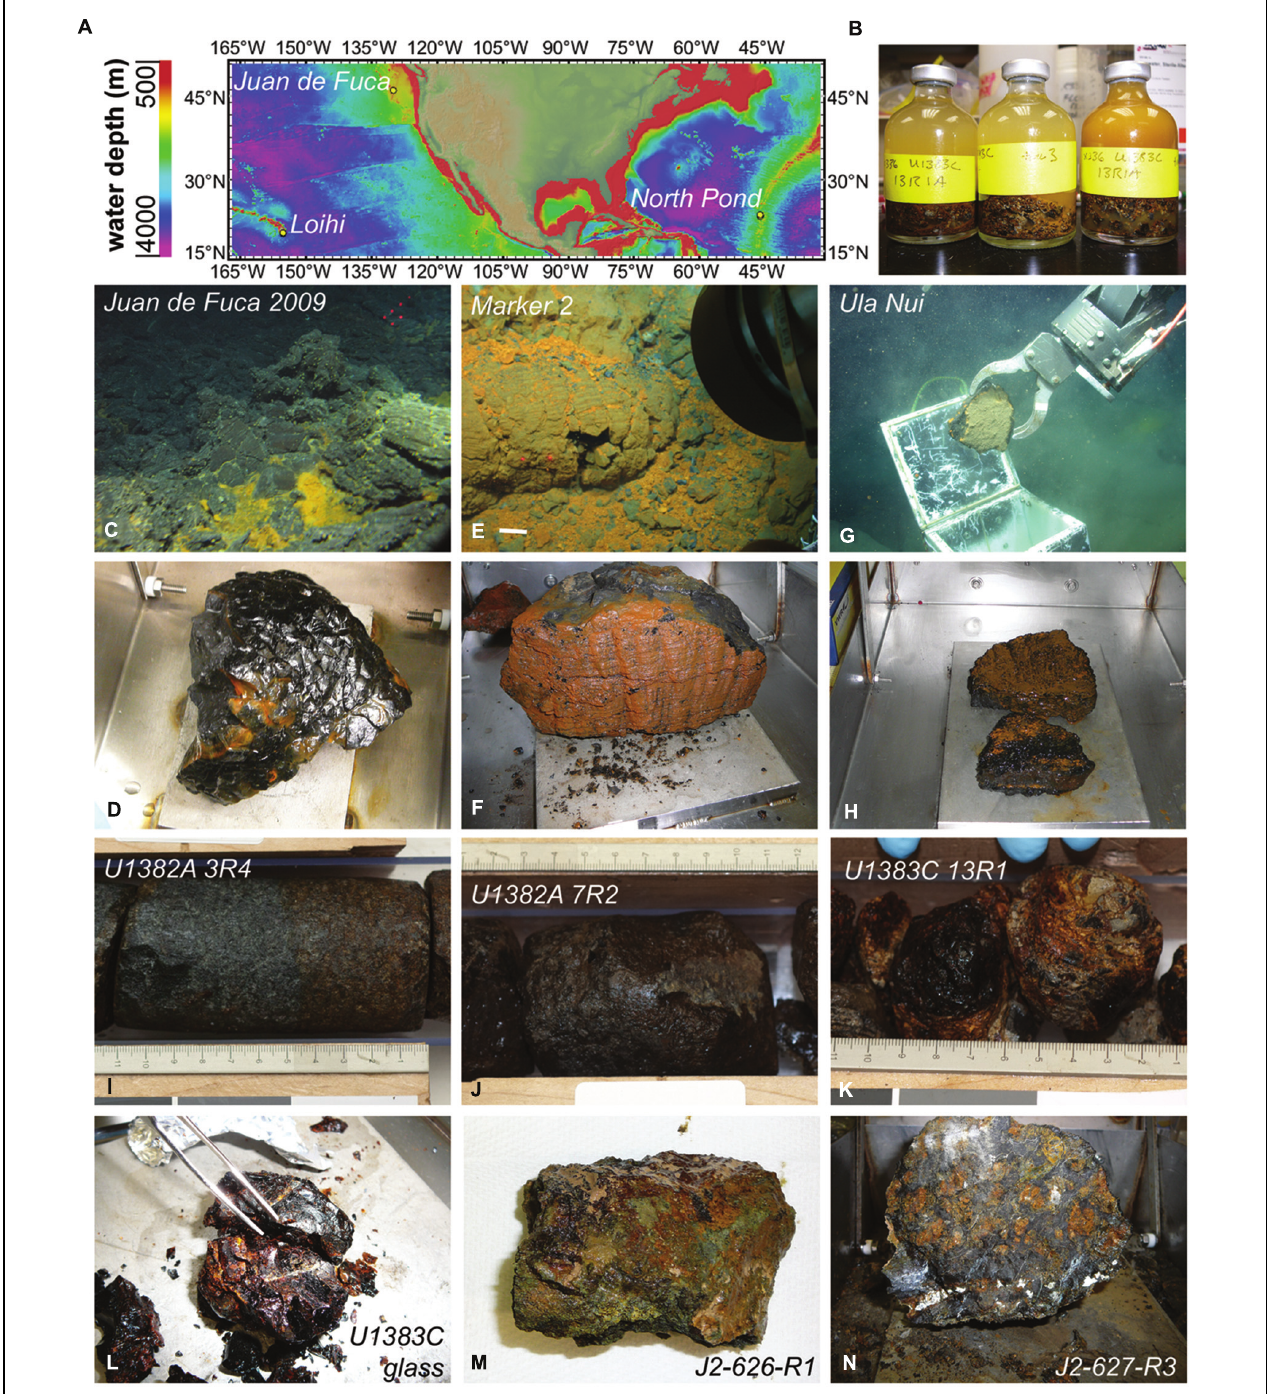
FIGURE 1 | Locations and photographs of samples used in the study. (A) Location map with bathymetry contours created using GeoMapApp (Ryan et al., 2009). (B) Example of sample incubation set up. (C) Location of glassy basalt (in D ) collected from the Juan de Fuca Endeavor Ridge. (E) Iron oxide stained basalts (in F ) collected from within Pele’s Pit on the summit of the Loihi Seamount offshore Hawai’i. (G) Collection of iron oxide stained basalt (in H ) from the Ula Nui ultradiffuse hydrothermal vent site at the base of the Loihi Seamount. Massive basalts with pervasive oxidation were collected from Hole U1382A sections 3R (I) and 7R (J) at North Pond, whereas glassy basalts were collected from Hole U1383C sections 13R (K) and 19-21R (L) . Manganese encrusted altered basalts were collected from the seafloor of North Pond on dives J2-626 (M) and J2-627 (N) . Photos in (B,D,F,H,L–N) by B. Orcutt; photos in (C,E,G) are copyright Woods Hole Oceanographic Institution; photos in (I–L) previously published (Expedition 336 Scientists, 2012c,d) and reprinted here with permission of the Integrated Ocean Drilling Program.